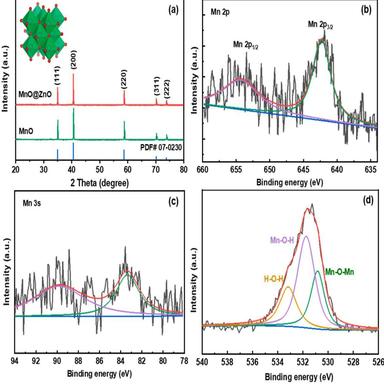
(a) XRD patterns of MnO and MnO@ZnO. Crystal structure of MnO (inset). XPS spectrum of (b) Mn 2p, (c) Mn 3s, and (d) O 2p of MnO@ZnO.